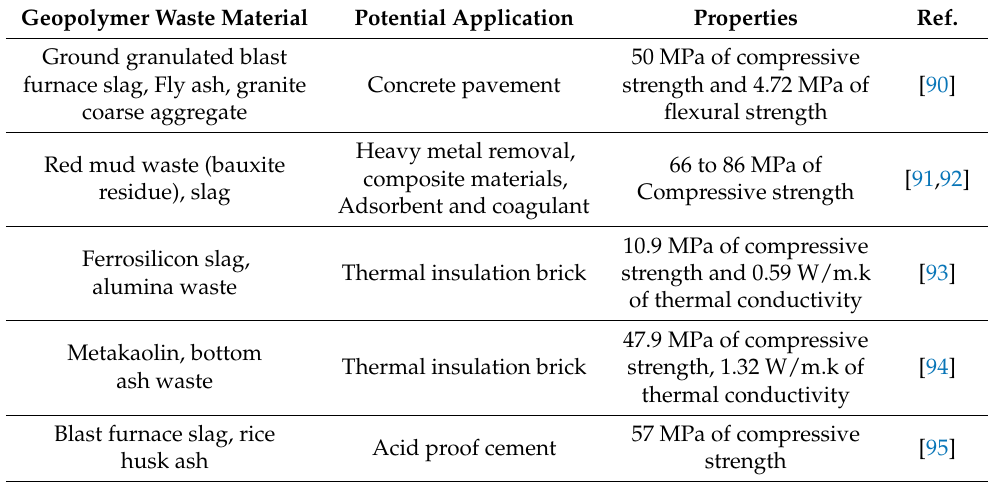
Table 4. The potential geopolymer material and possible application are described in